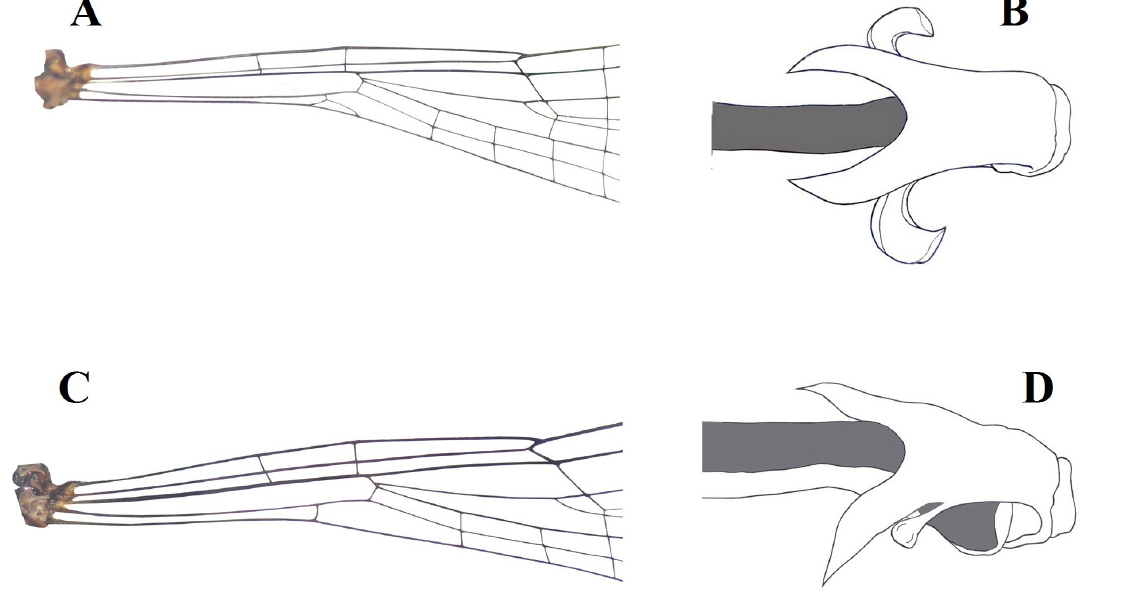
Fig. 10. Wings base and genital ligula of Prodasineura Cowley, 1934 spp., males, holotypes A–B . P.